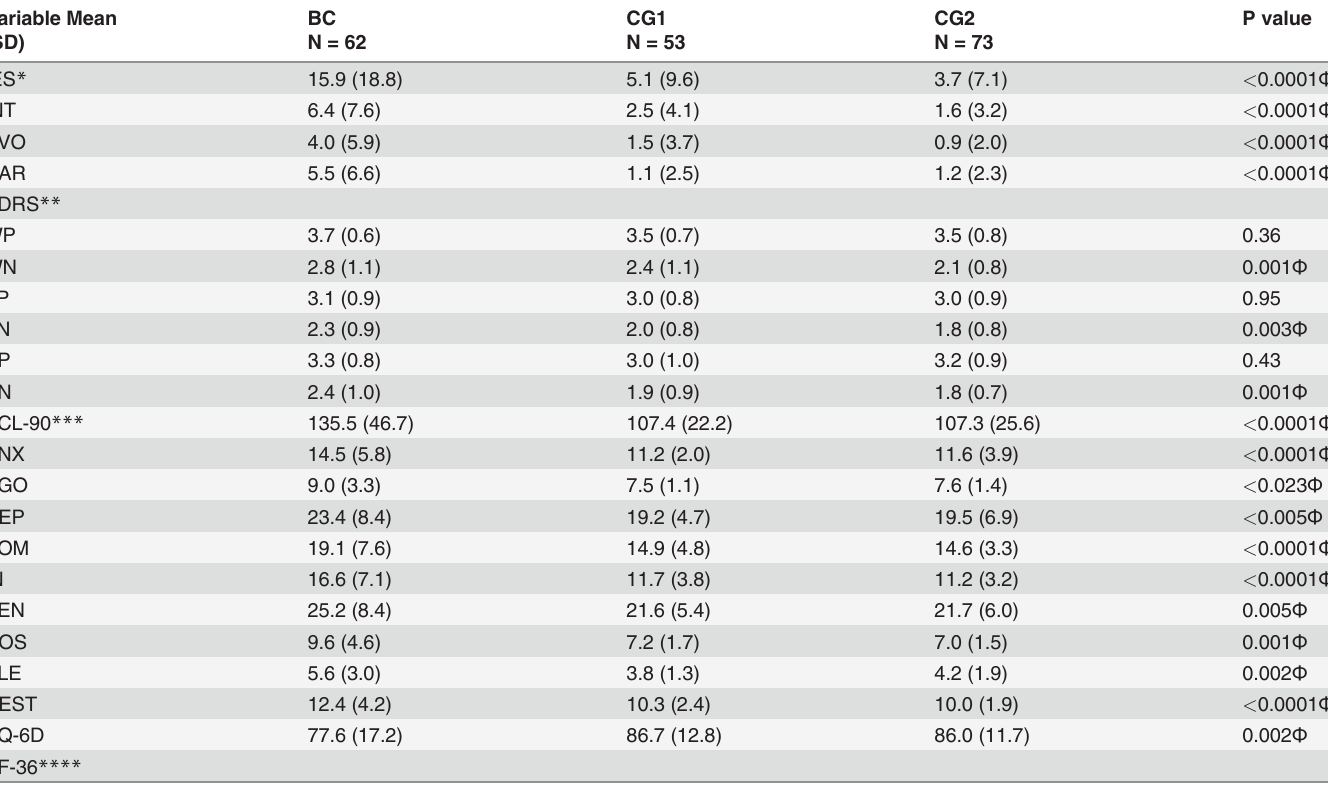
Table 3. Scores of IES, PDRS, SCL-90, EQ-6D and TIC-P per subgroup. Variable